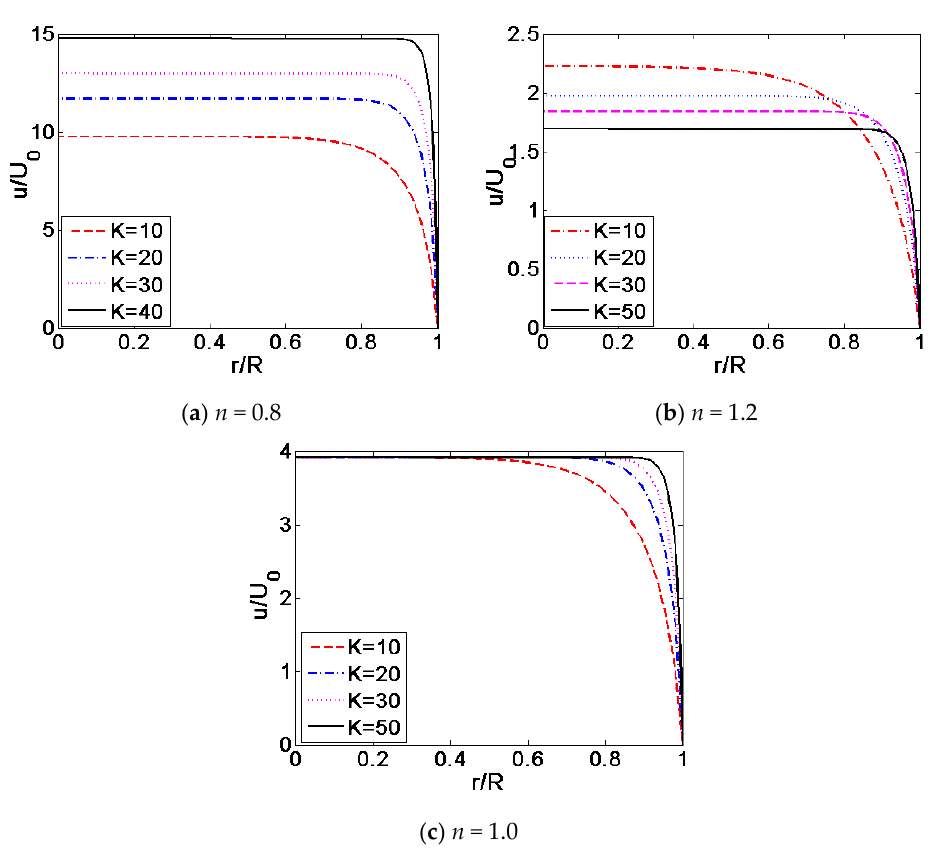
Figure 6. The comparison of the velocity profiles for various width ratio K under the situation of various flow behavior index n ( = − 4): ( a ) n = 0.8; ( b ) n = 1.2; ( c ) n = 1.